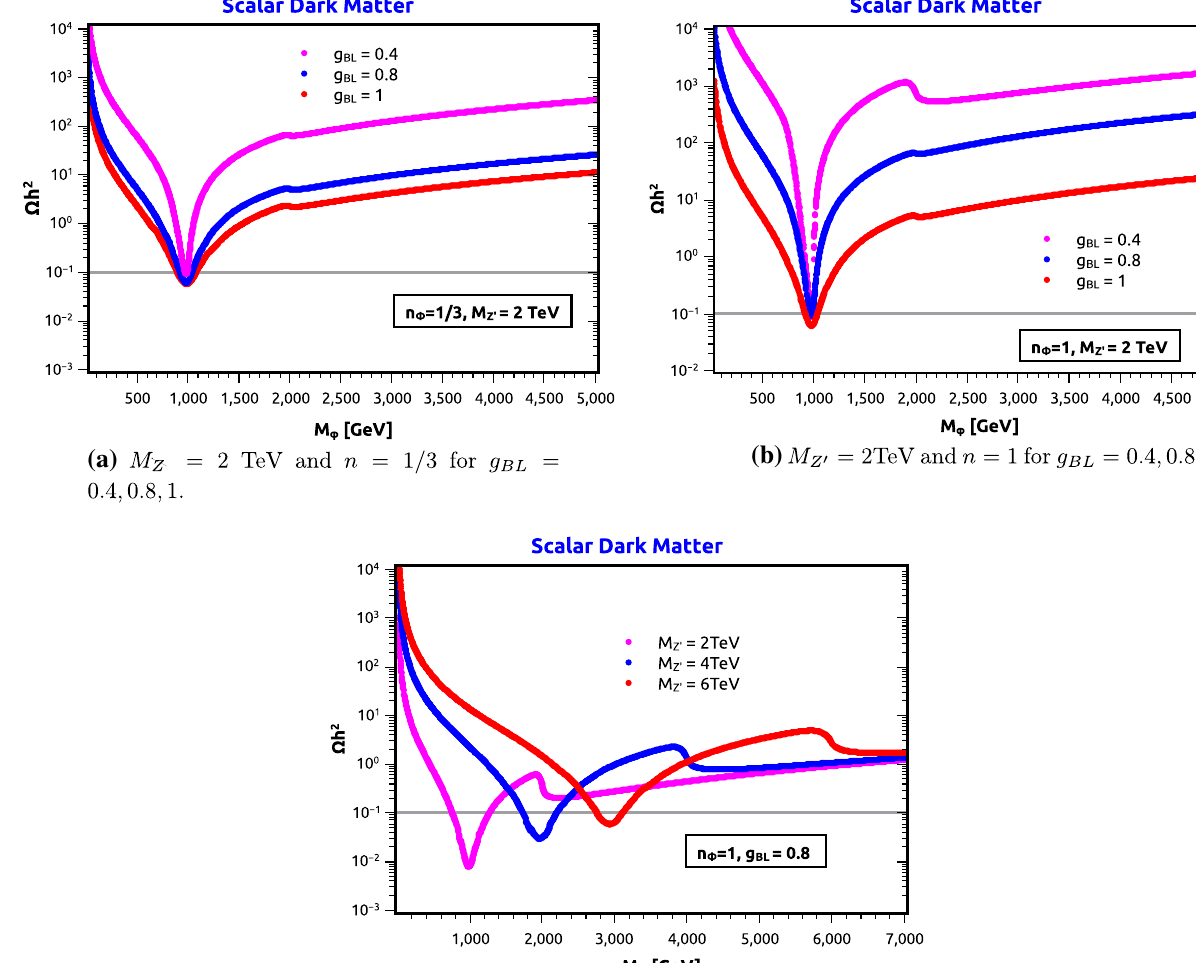
n 4 φ . Having these expressions at BL